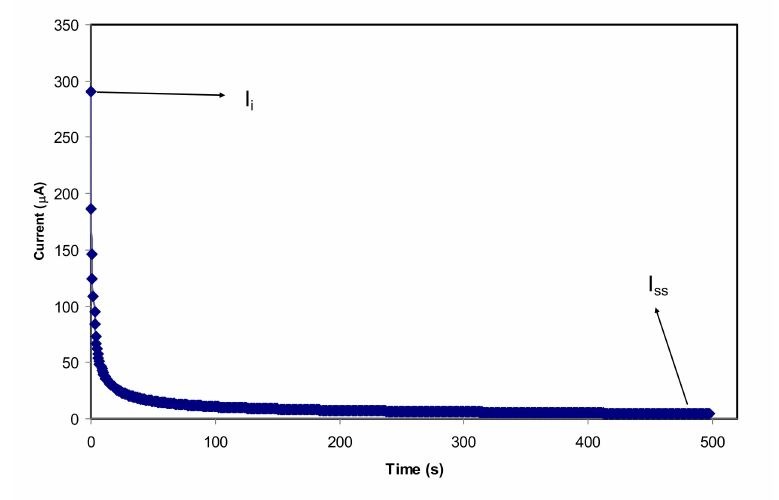
Figure 8. Polarization current for the CSAG4 sample with the highest conductivity versus